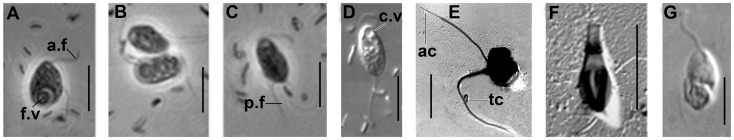
Light and electron micrographs of colponemids.(a–f) Colponema edaphicum: a) large food vacuole is visible, b) cell division, (c, d) two heterodymanic flagella and (e, f) extrusive organelle toxicyst (TEM), ((a–c), f) from Tikhonenkov et al. [64], (d, e) from Mylnikov et al. [65]; g) Colponema marisrubri (from Mylnikov and Tikhonenkov [25]). a.f – anterior flagellum, f.v – food vacuole, p.f – posterior flagellum, c.v – contractile vacuole, ac – acronema, tc – toxicyst. Scales: (a–e), g) –10 µm; f) –1 µm.